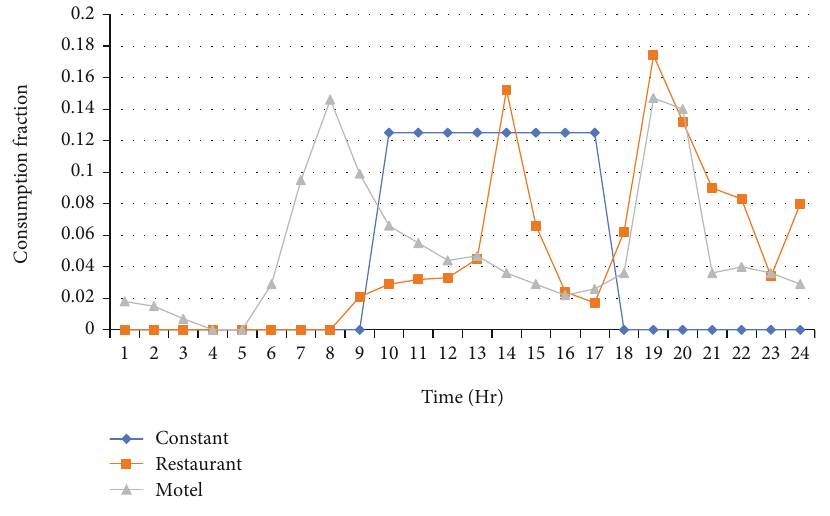
Figure 6: Hot water consumption pattern for three selected cases. Table 4: COP of the heat pump on selected days by taking max and minimum.